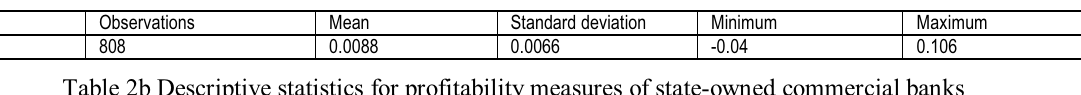
Table 2d Descriptive statistics for profitability measures of city commercial banks